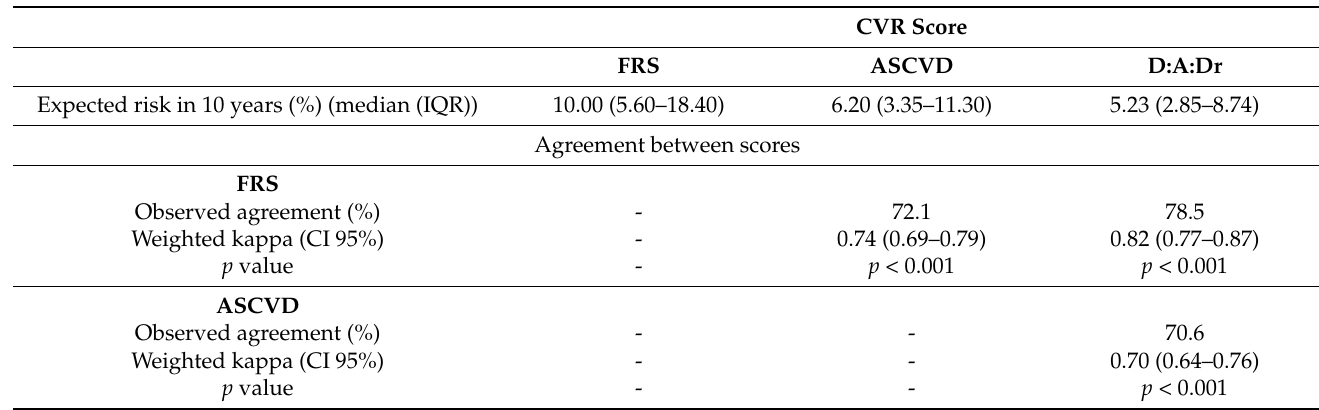
Table 4. Agreement rate between the thee CVR stratification